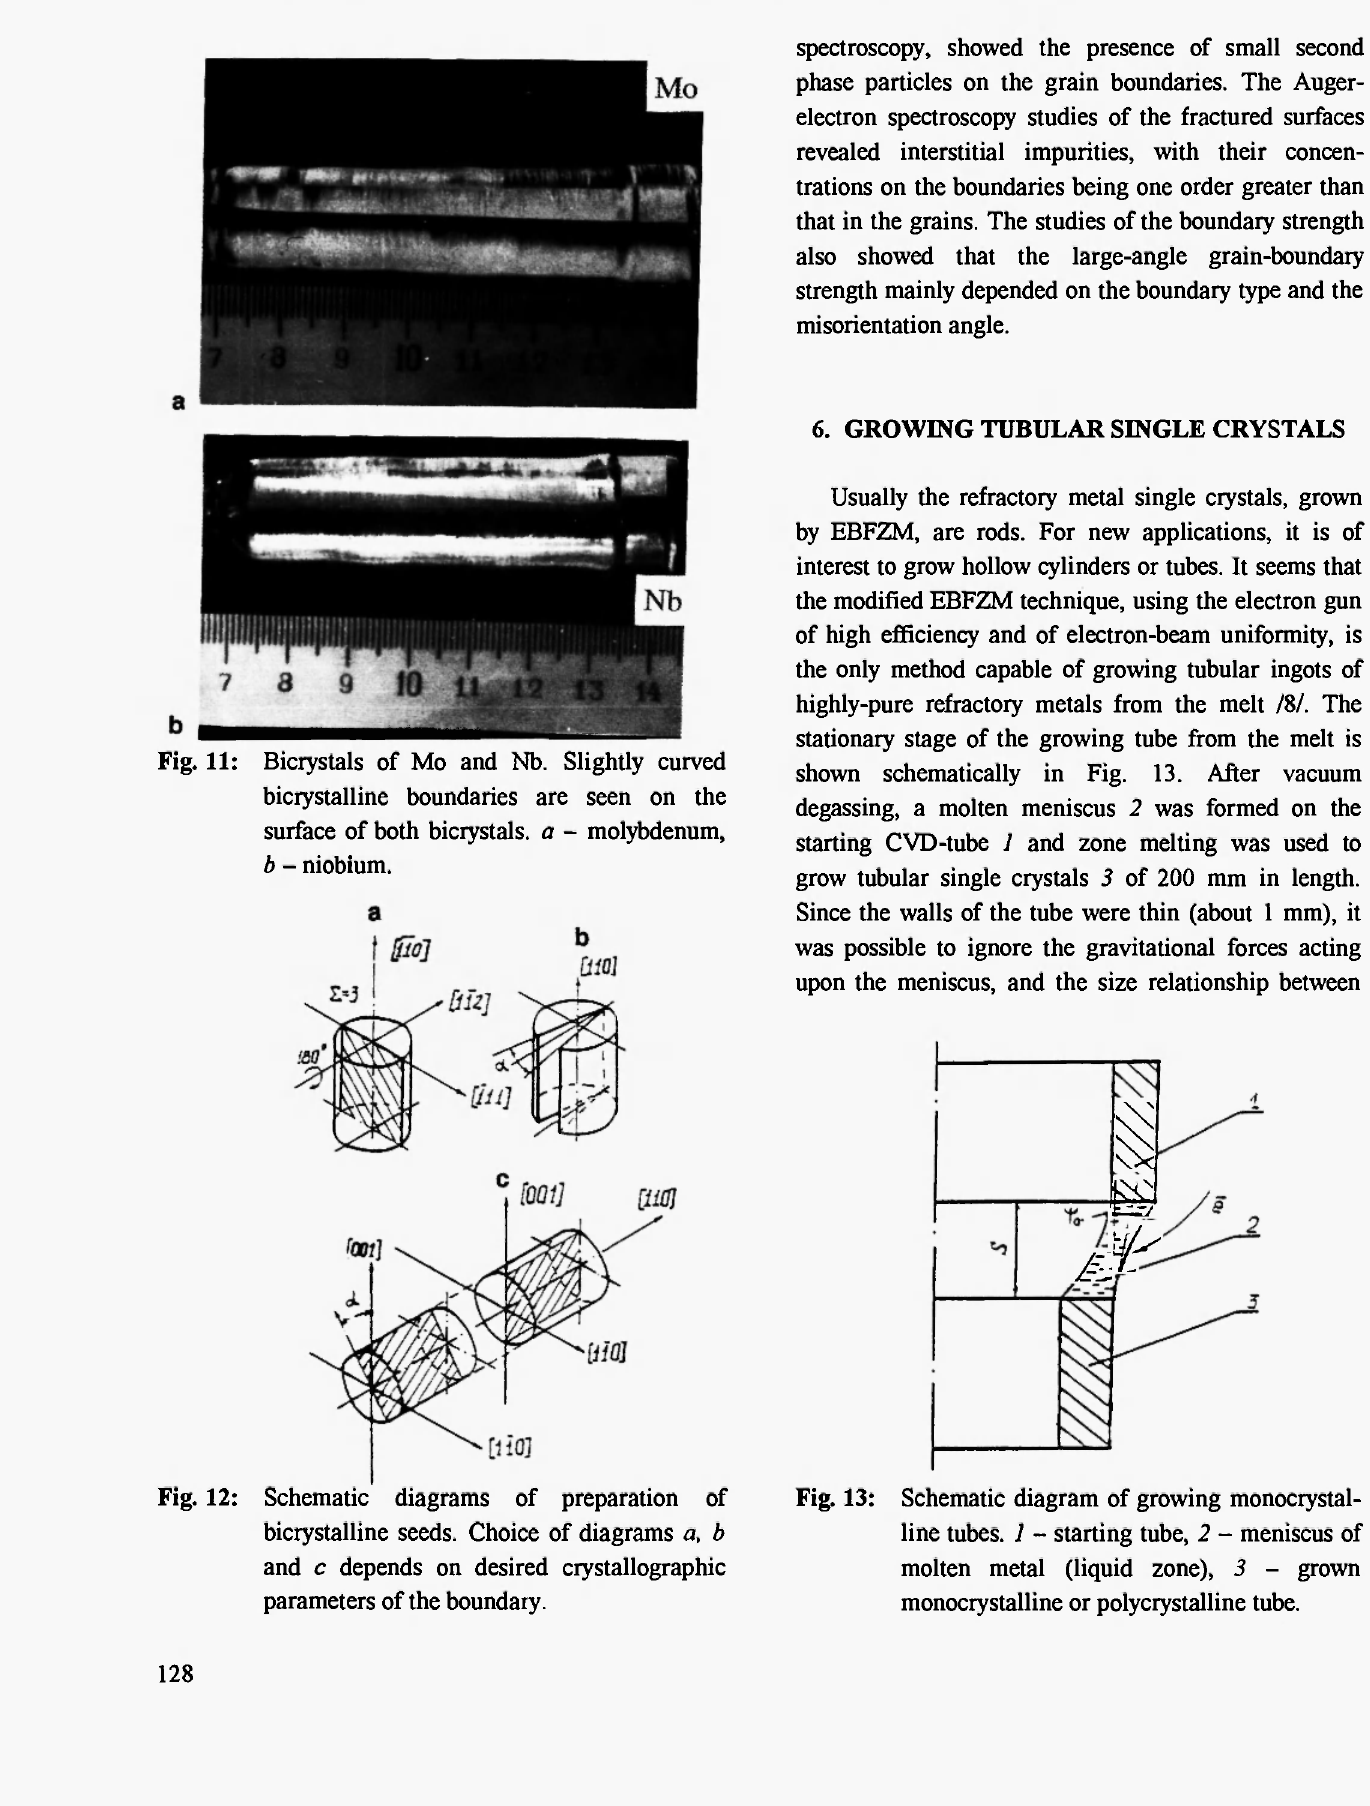
Fig. 13: Schematic diagram of growing monocrystal- line tubes. 1 - starting tube, 2 - meniscus of molten metal (liquid zone), 3 - grown monocrystalline or polycrystalline